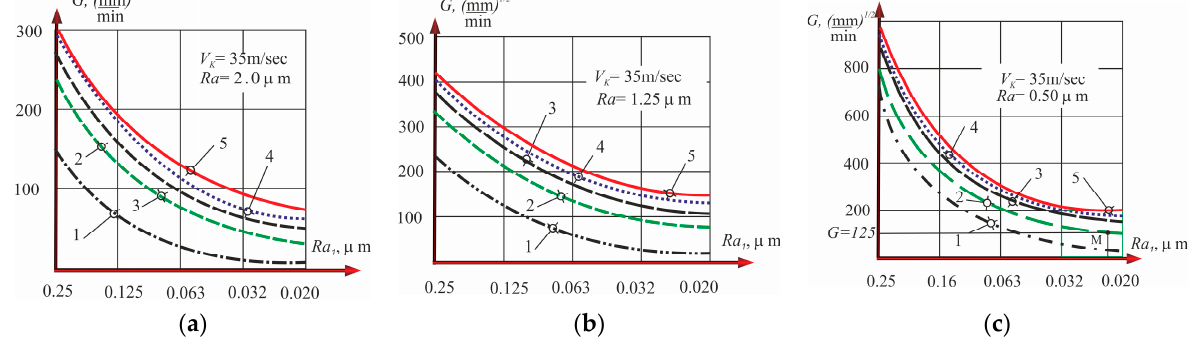
Figure 8. The dependence of the performance indicator on the surface roughness after grinding, and the number of finishing operations with preliminary roughness: ( a ) 𝑅𝑎 = 0.63 µm, ( b ) 𝑅𝑎 = 0.32 µm, ( c ) 𝑅𝑎 = 0.16 µm: 1:𝑛 = 1 ; 2 : 𝑛 = 2 ; 3: 𝑛 = 3; 4: 𝑛 = 5; 5 : 𝑛 = 10 ; 𝑉 (cid:3012) = 35 m/min). the number of finishing operations with preliminary roughness: ( a ) Ra = 0.63 µ m, ( b ) Ra = 0.32 µ m, ( c ) Ra = 0.16 µ m: 1 : n = 1; 2: n = 2; 3 : n = 3; 4 : n = 5; 5: n = 10; V K = 35 m/min).